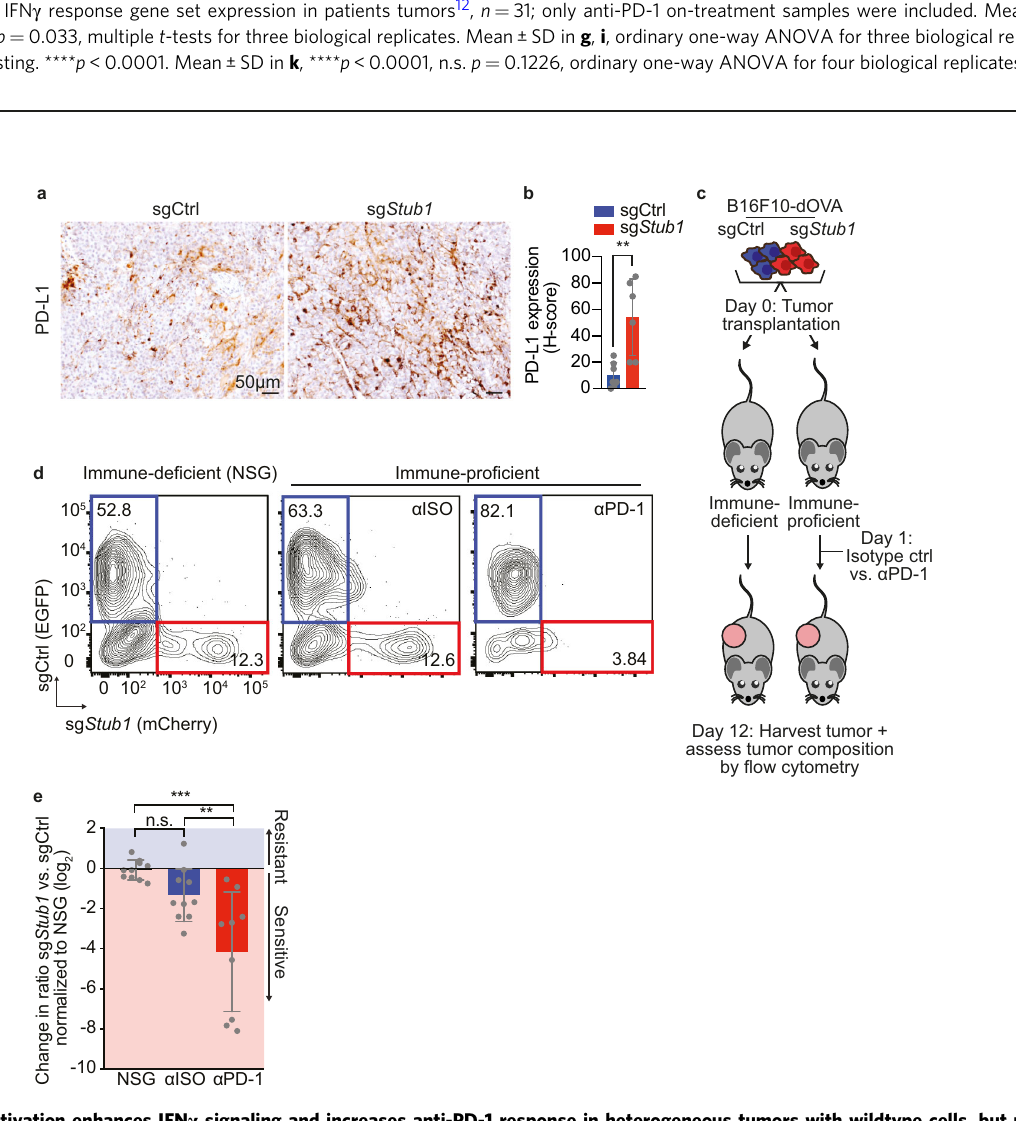
Fig. 5 STUB1 inactivation enhances IFN γ signaling and increases anti-PD-1 response in heterogeneous tumors with wildtype cells, but not in homogenous STUB1-de fi cient tumors. a Immunohistochemistry images of either sgCtrl or sg Stub1 -expressing B16F10-dOVA tumors in vivo. Tumor samples were stained for PD-L1. b Quanti fi cation using H-score of PD-L1-positive tumor cells in tumor samples depicted in a . c Schematic depiction of the in vivo competition assay modeling anti-PD-1 response with B16F10-dOVA cells expressing either sgCtrl or sg Stub1 , which were differentially labeled with EGFP and mCherry, respectively. d Flow cytometry plots from each group of the in vivo experiment outlined in c NSG, Isotype control-treated ( α ISO), anti- PD-1-treated ( α PD-1). Number in quadrants indicates % of parent population. e Quanti fi cation of in vivo competition assay outlined in c . Ratios of mCherry vs. EGFP were normalized to the NSG condition. Mean± SD in b , ** p = 0.003, unpaired two-tailed t -test, n = 7 for sgCtrl and n = 6 for sg Stub1 . Mean± SD in e , *** p = 0.0002, ** p = 0.0073, n.s. p = 0.2985, ordinary one-way ANOVA with Tukey post hoc testing for n = 10 in NSG and α ISO and n = 9 in α